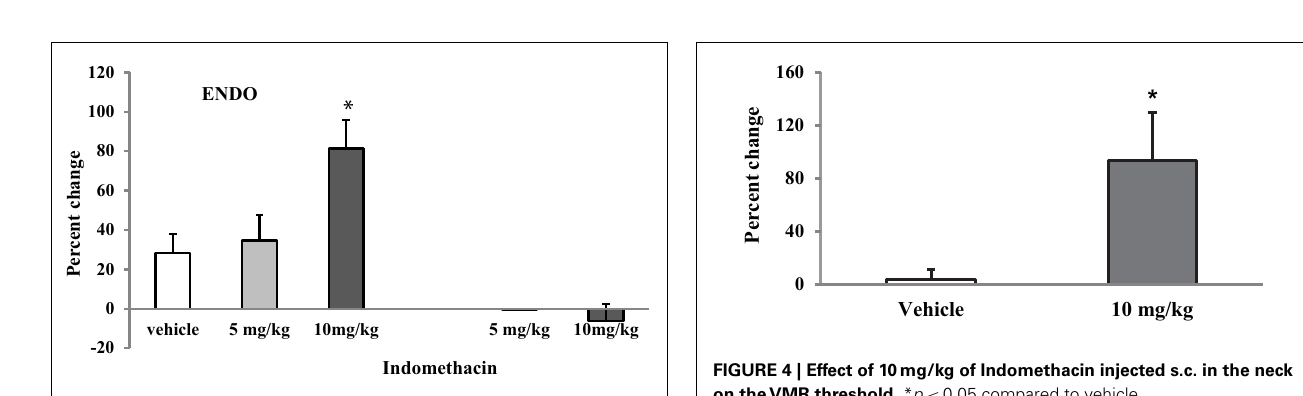
FIGURE 2 | Estrous variations inVMR to vaginal distention (Volume threshold) in rats > 8weeks after ENDO or shamENDO surgery. Baseline thresholds were measured across the estrous cycle over 3–5weeks and then averaged for each estrous stage (i.e.,